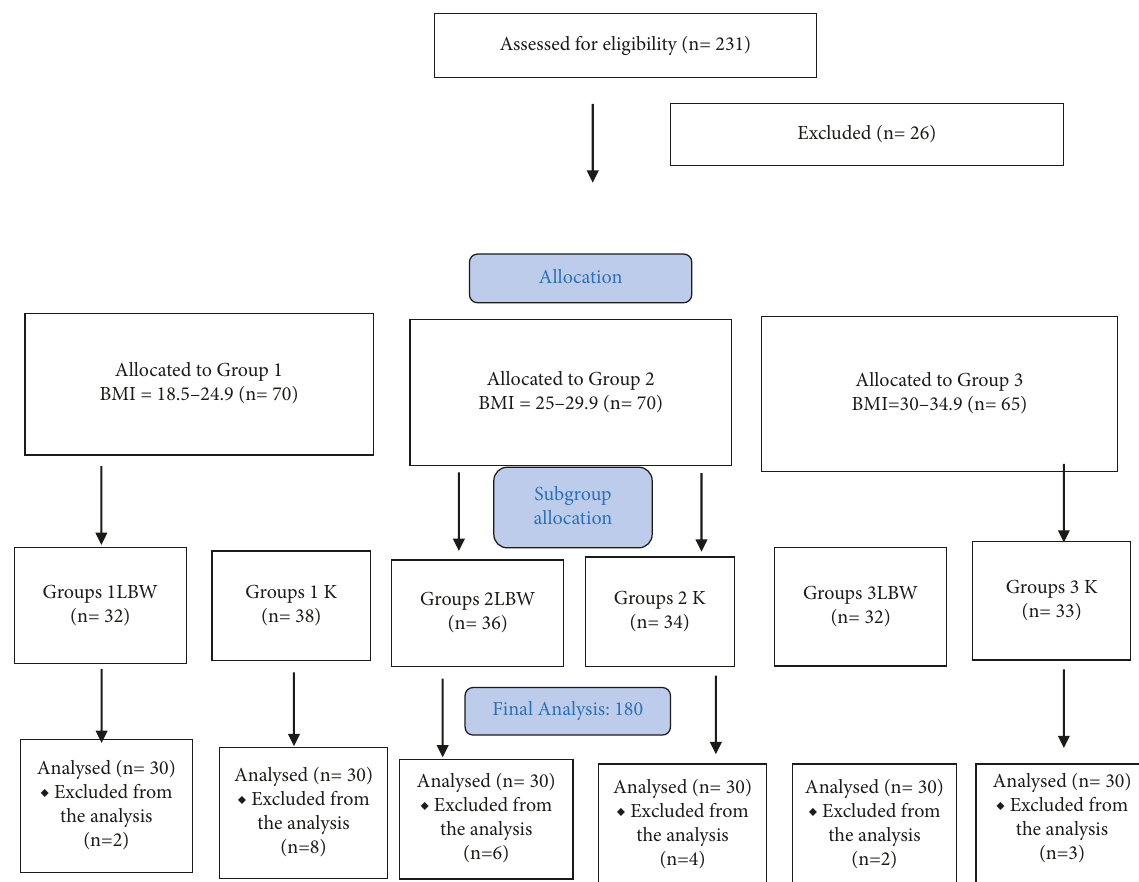
Figure 1: Flowchart.